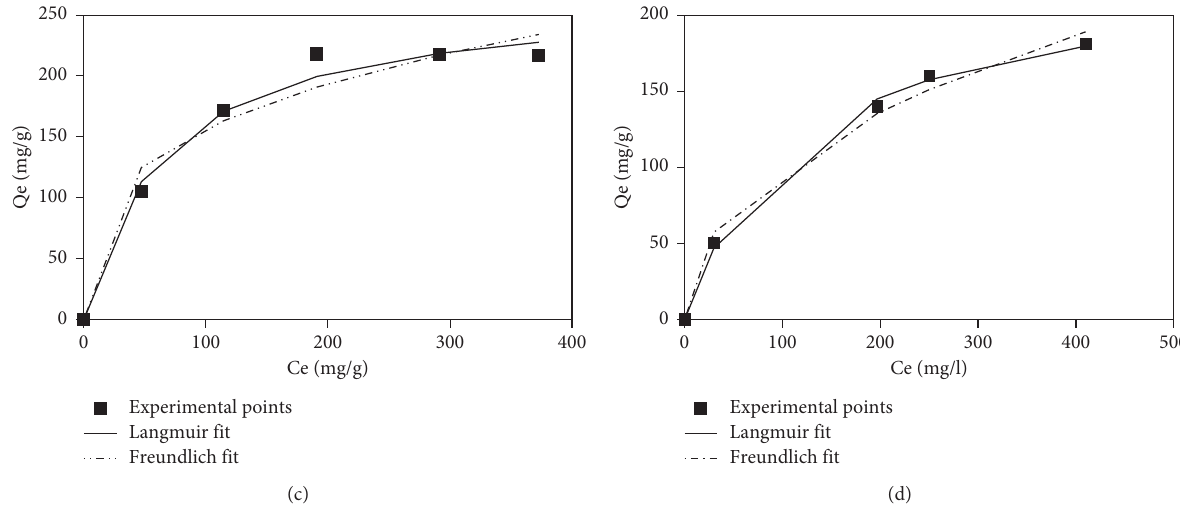
Figure 7: Isotherm sorption of BB onto A-NaOH (a), BB onto A-HCl (b), MB onto A-NaOH (c), and MB onto A-HCl (d).